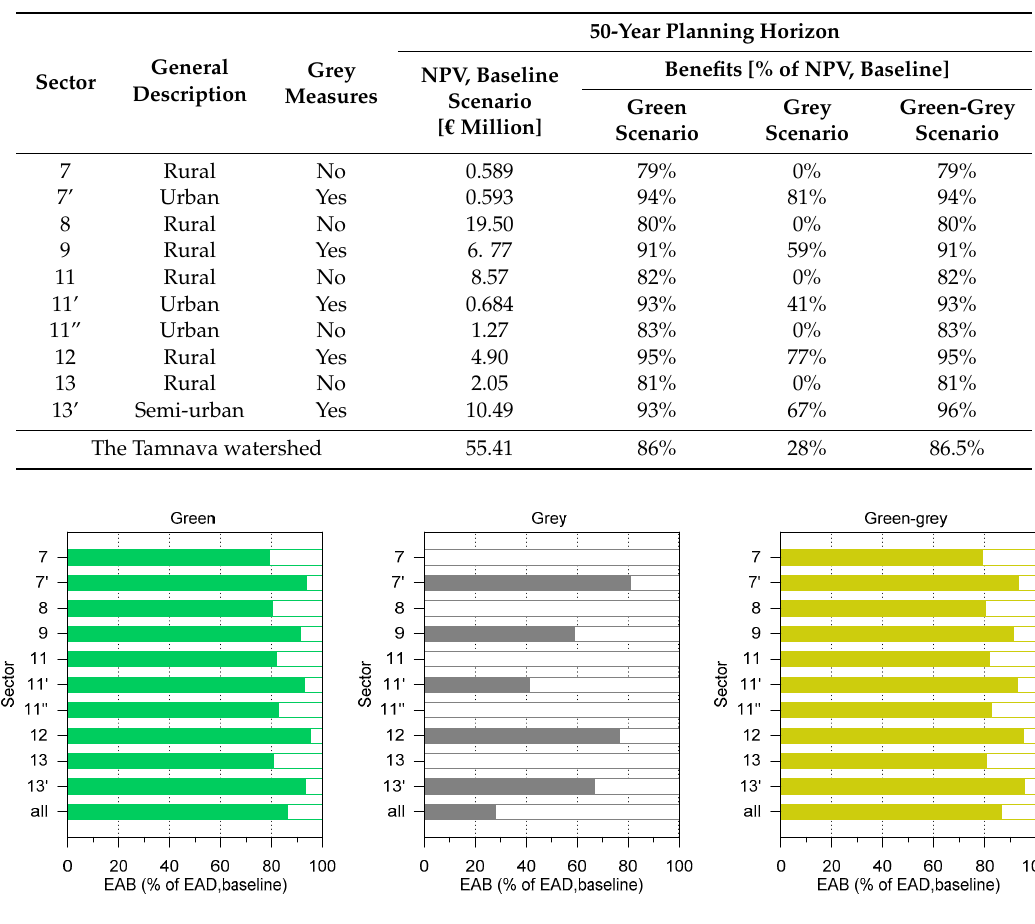
Figure 12. Expected annual benefits EAB, expressed relative to the expected annual damages EAD under the baseline scenario, from implementing different flood mitigation measures in different river sections and in the entire Tamnava watershed.